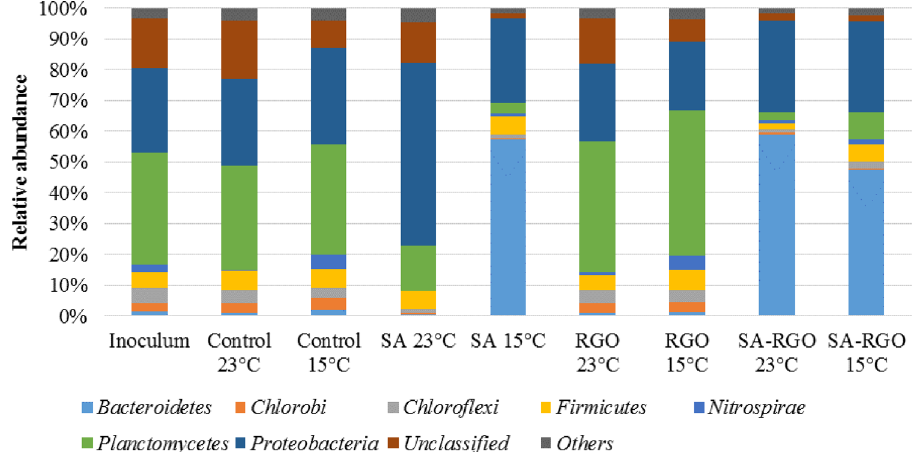
Figure 6. Microbial community composition at a phylum level in the inoculum and investigated SBRs at 23 °C and 15 °C: control reactor, a reactor with RGO addition, a reactor with biomass immobilized in SA, and a reactor with biomass immobilized in RGO.